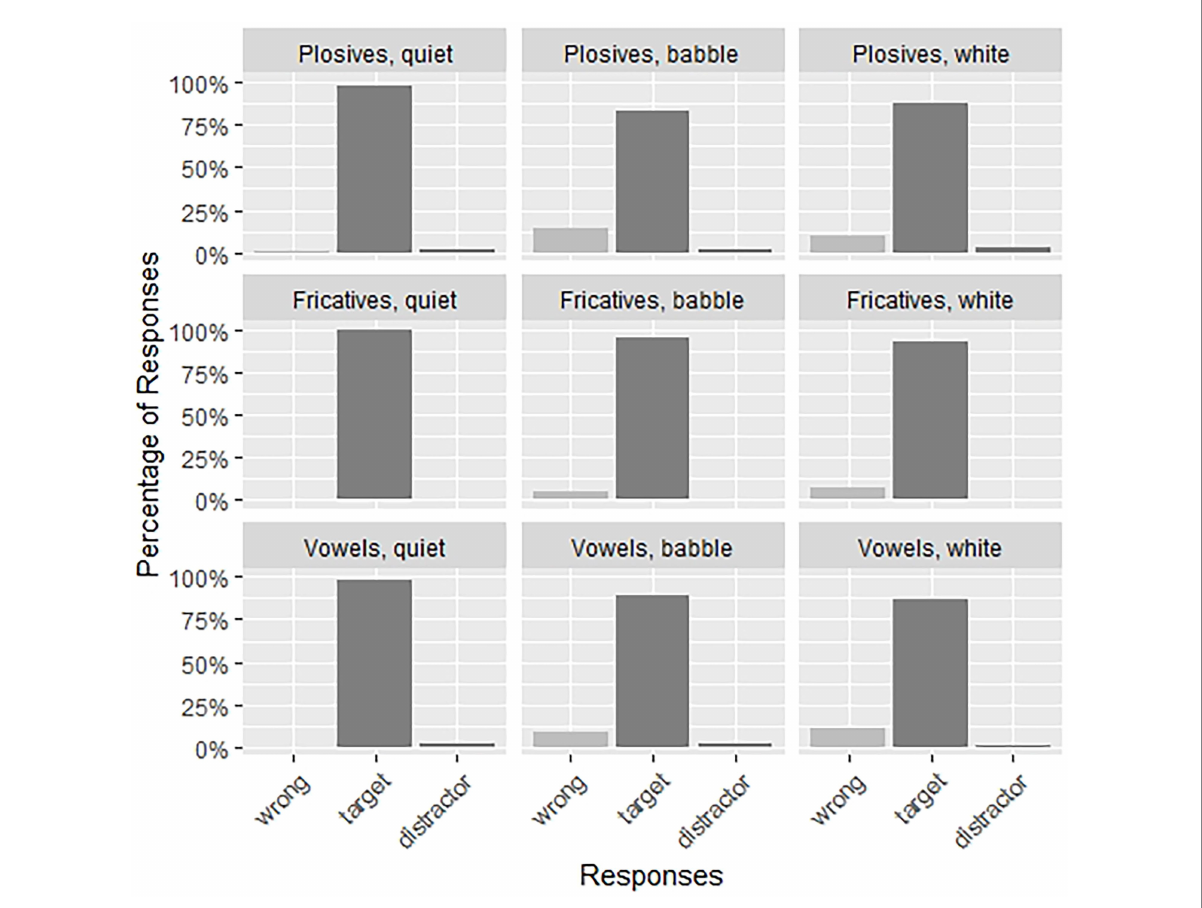
FIGURE 2 The proportion of participants’ responses (wrong, target, and distractor) for each of the three noise conditions (quiet, babble, white noise) and three sound types (plosives, fricatives, vowels) for the high predictability